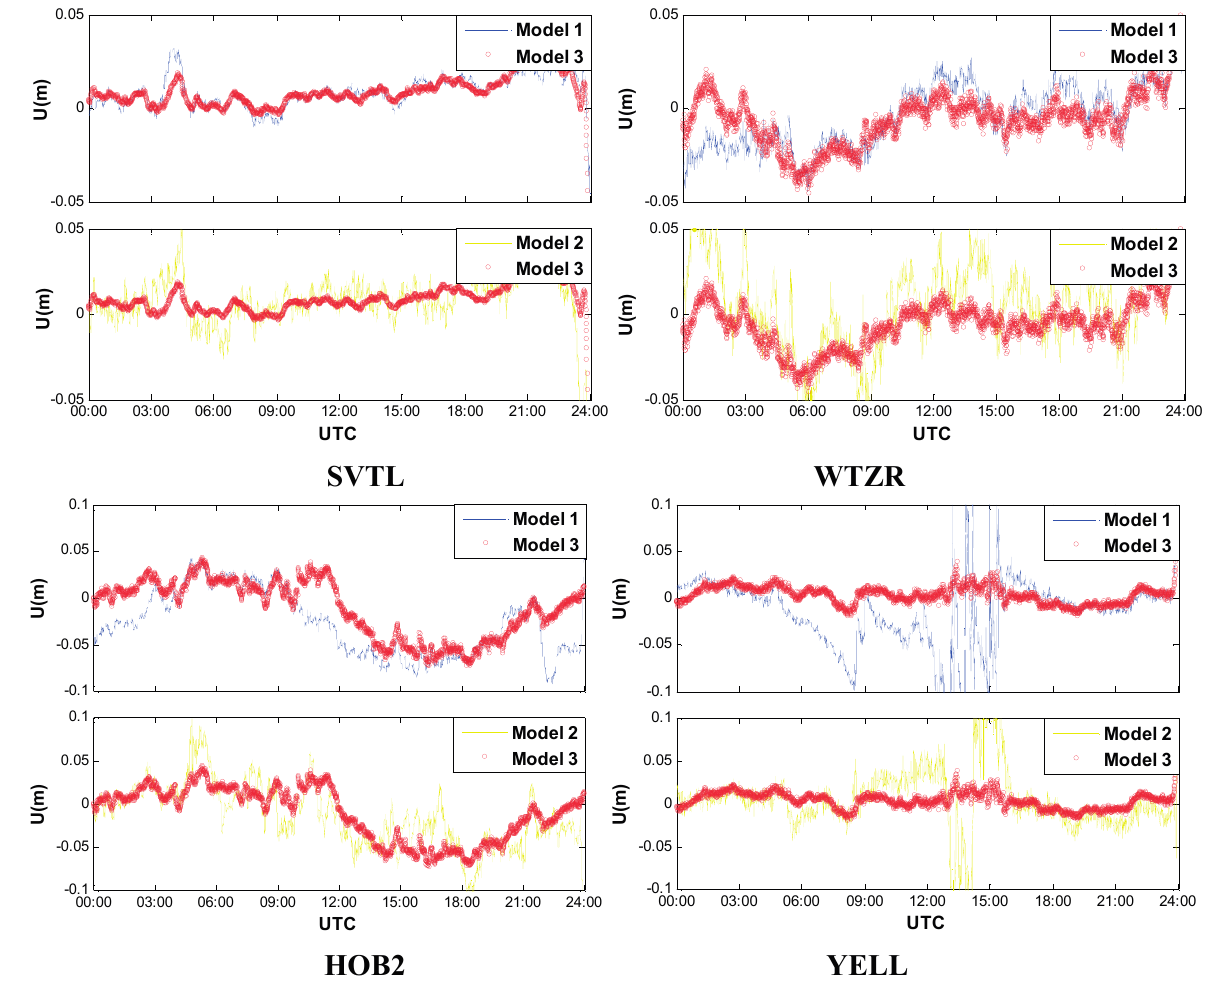
Figure 3. Vertical positioning errors of kinematic PPP with forward and backward smoothing Kalman filter.